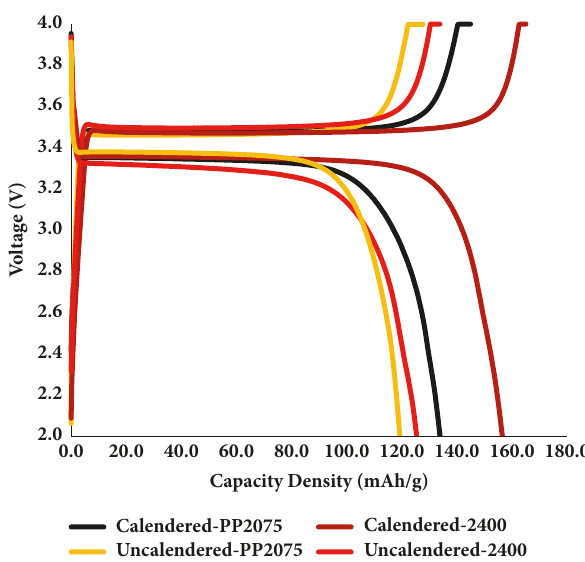
Figure 3: Charge and discharge performance of LFP batteries assembled with monolayer separators PP2075 and 2400.